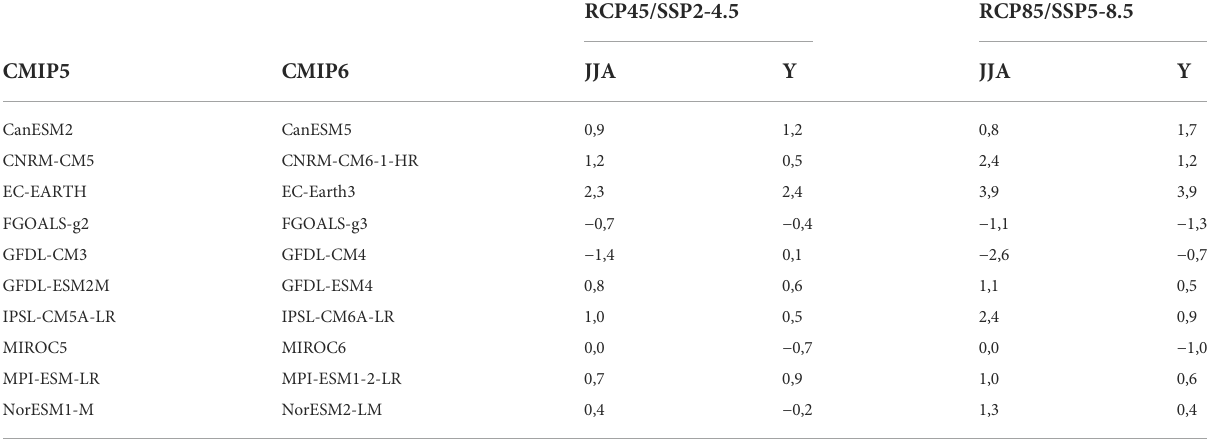
TABLE2DifferencesinTASprojectedchanges( ° C)betweenselectedCMIP6aCMIP5GCMpairsfortwoforcingscenarios.Positivevaluesimplyhigher projected changes in CMIP6 than in CMIP5. JJA denotes mean over June-July-August season, Y denotes annual mean.